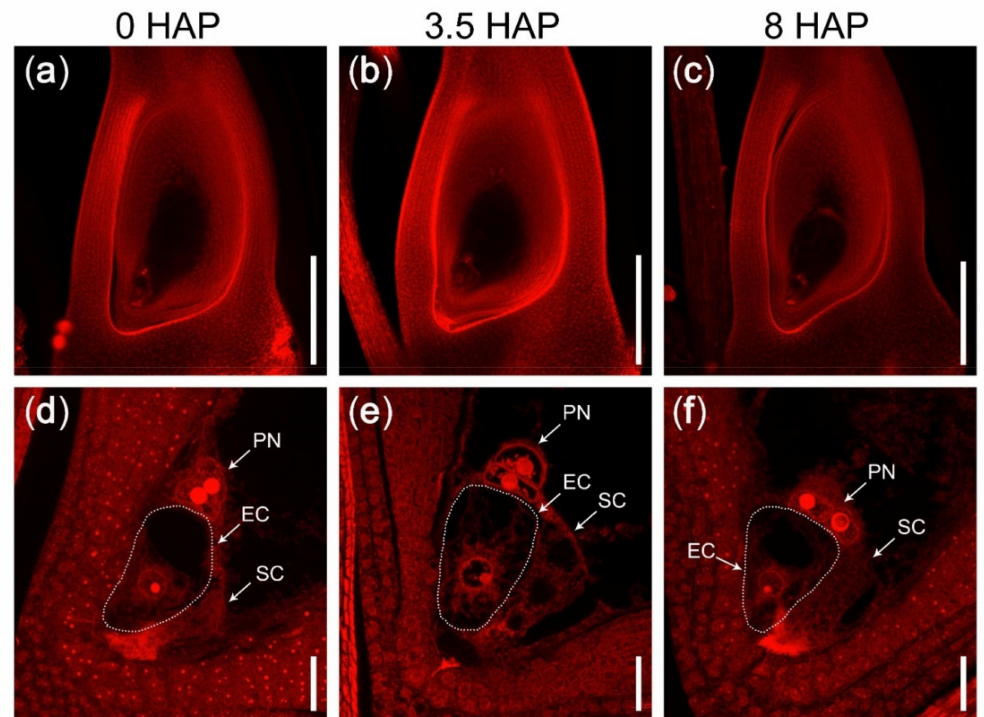
Figure 2. The mutant feb failed to complete double fertilization in rice. ( a , d ) The mature embryo sac with egg cell and polar nuclei developed normally in the mutant feb . ( b , c , e , f ) The mutant embryo sac remained unfertilized at 3.5 HAP ( b , e ) and at 8 HAP ( c , f ). ( a – c ) CLSM photos of ovaries stained with eosin B at 10 × lens magnification. ( d – f ) The micropylar part of embryo sacs in ( a – c ) at 63 × lens magnification. The dotted lines indicated the egg cell. EC, egg cell; PN, polar nuclei; SC, synergid cell. Scale bars = 200 µ m in ( a – c ); 20 µ m in ( d – f